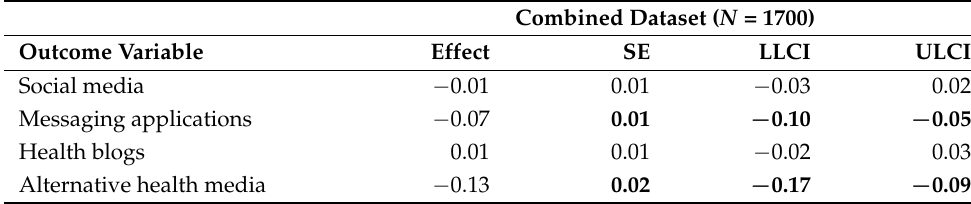
Table A6. The mediation effect of vaccination behavior on media reliance for COVID-19 news.